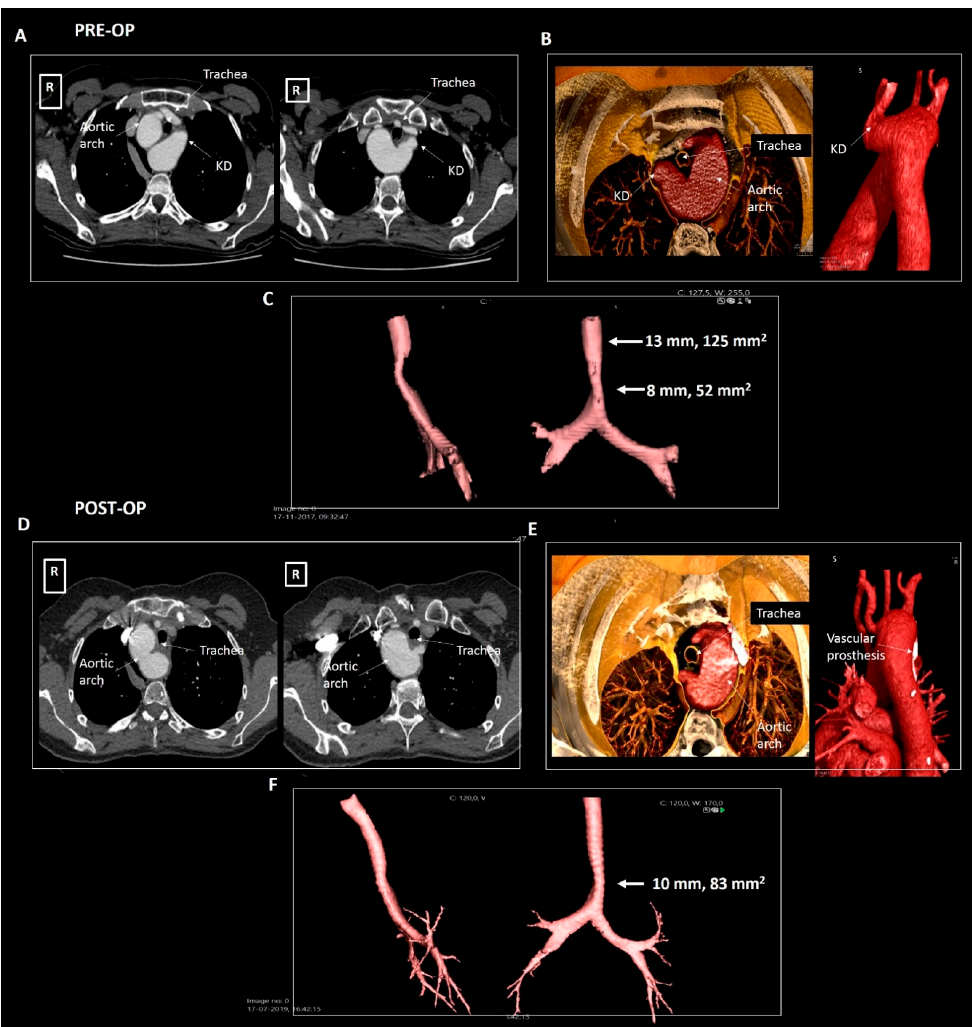
Figure 5. Patient 3. Panels ( A – C ) pre-operative imaging, panels ( D – F ) post-operative imaging. Panel ( A ) shows the axial reconstructions illustrating a right-sided aortic arch, aberrant left subclavian artery and a Kommerell’s diverticulum compressing the trachea and esophagus. Panel ( B ) shows the volume rendering images and panel ( C ) depicts the compressed trachea. Panel ( D ) shows the post-operative result after surgical resection of the Kommerell’s diverticulum in axial reconstructions and panel ( E ) in volume rendered reconstructions. Panel ( F ) depicts the trachea, illustrating some increase in tracheal dimensions. KD, Kommerell’s diverticulum.